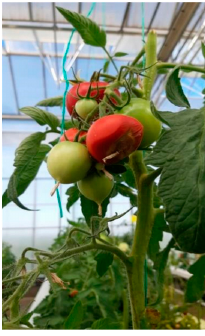
Figure 4. Blossom end rot, a physiological disorder induced by calcium deficiency in tomato fruits.